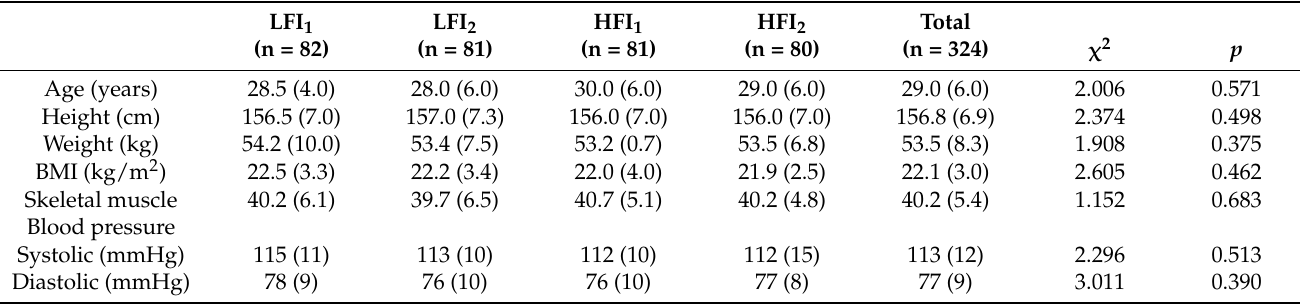
Table 2. Characteristics of participants.